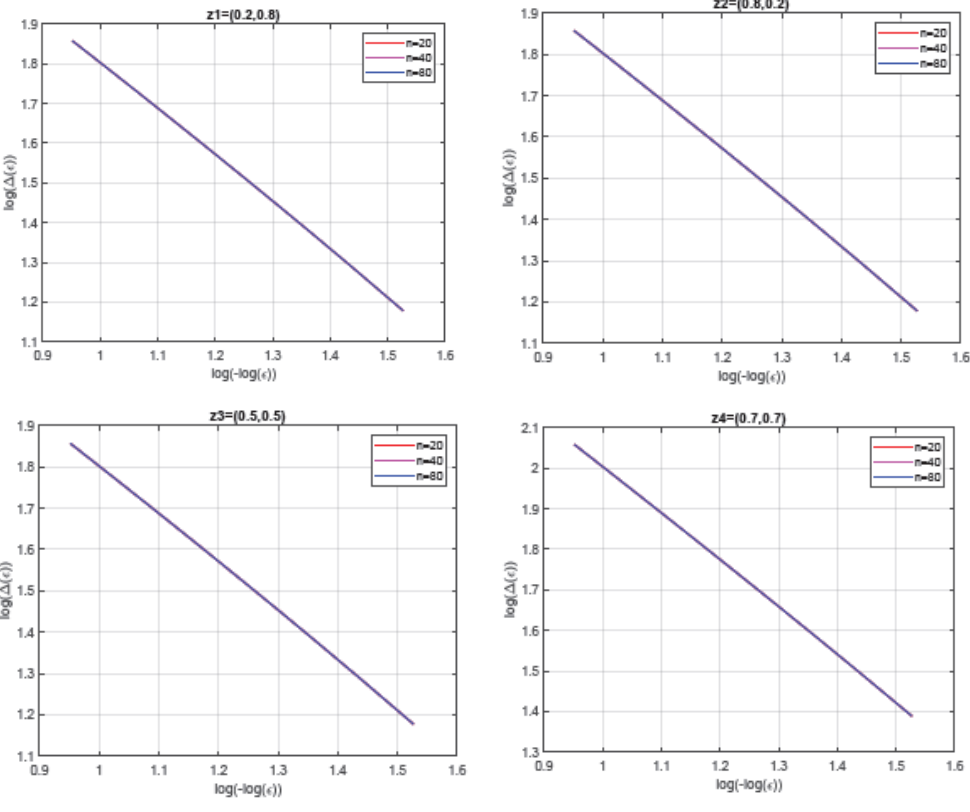
( ε ) | ) relating to log(−log( ε )) i